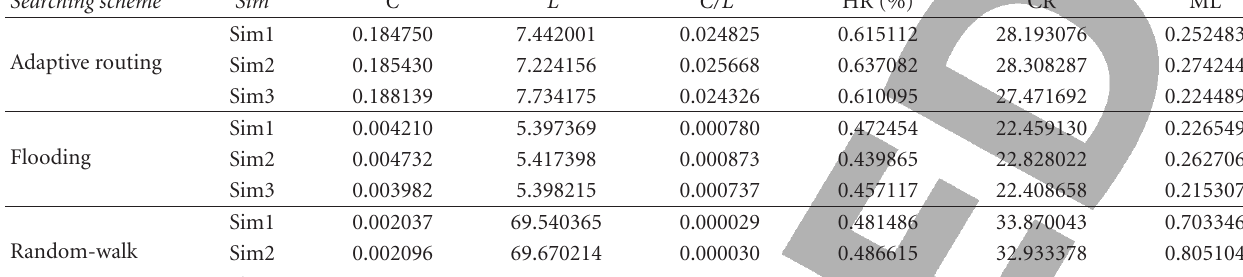
Table 4: Evolution of topological